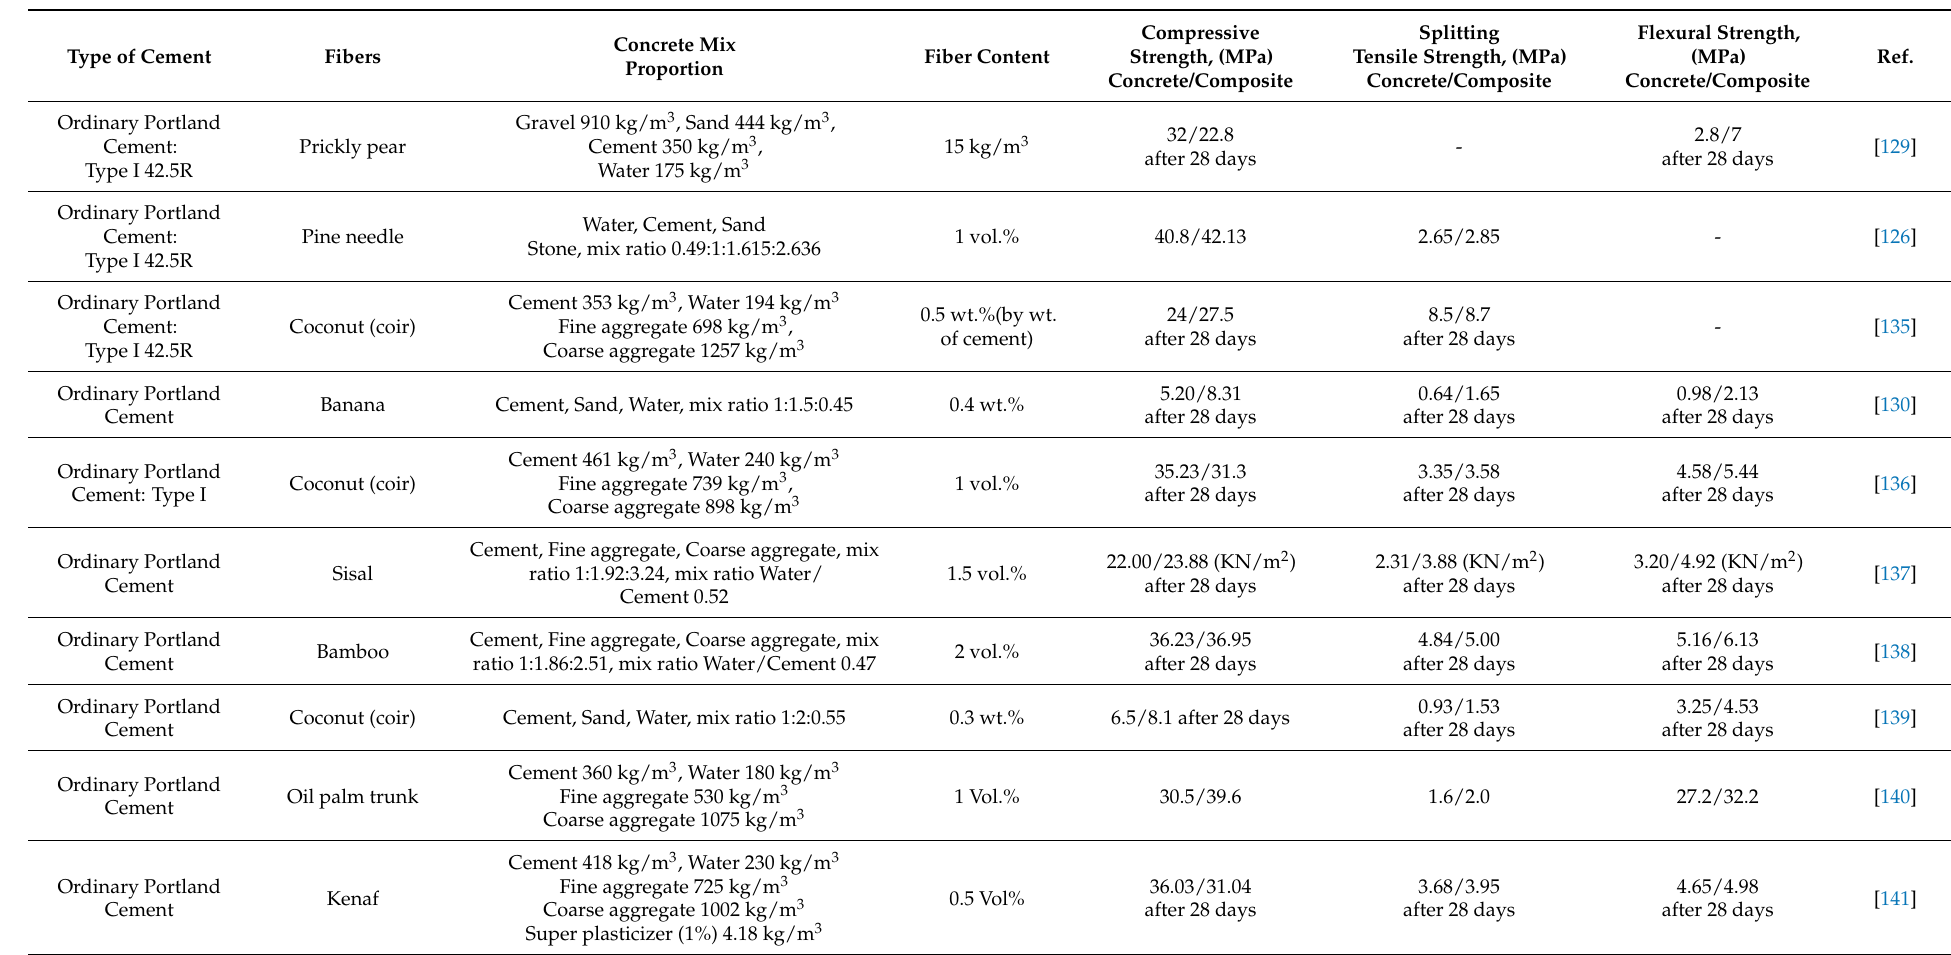
Table 3. Mechanical properties of cement composites with vegetable fibrous filter, based on